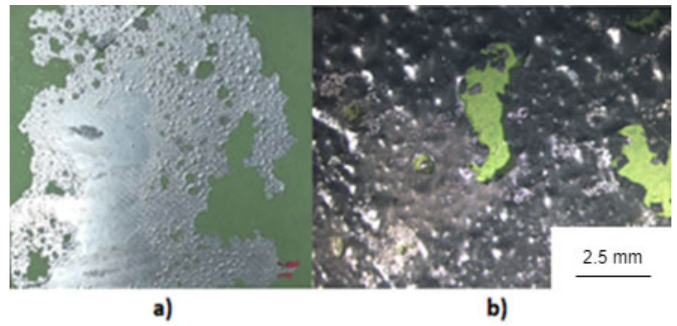
Figure 15. View of sample 8 (( a ): whole sample, ( b ): detailed microscopic view).